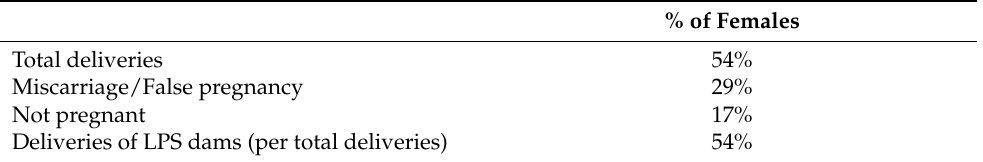
Table A1. Success rate in